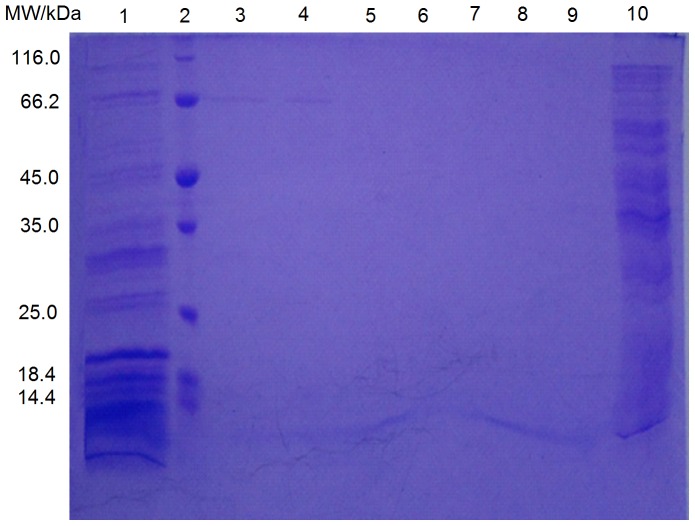
SDS-PAGE analysis of β
2-AR solution.Lane 1, collection from Ni2+ Sepharose 6 Fast Flow column eluted by 50% buffer B; Lane 2, protein molecular weight marker (the molecular weights from top to bottom are 116.0, 66.2, 45.0, 35.0, 25.0, 18.4 and 14.4 kDa, respectively); Lane 3–4, collection from Quaternary Sepharose Fast Flow column gradient eluted by 18%–40% buffer C; Line 5–9, collection from Quaternary Sepharose Fast Flow column eluted by 50%, 60%, 70%, 80% and 90% buffer C; Lane 10, β
2-AR supernatant.